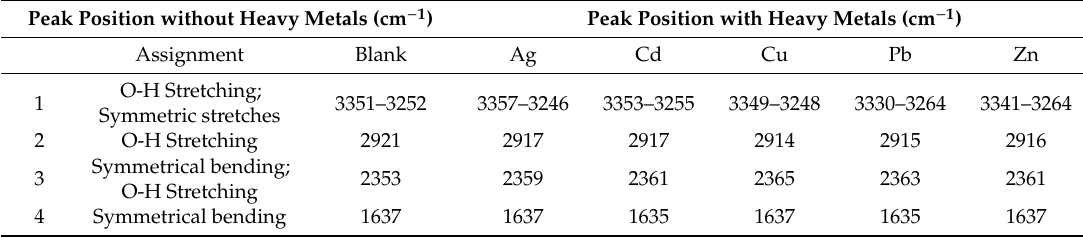
Table 1. Bands width and the peak positions in the Attenuated Total Reflectance (ATR) / FT-IR spectra. Peak Position without Heavy Metals (cm − 1 ) Peak Position with Heavy Metals (cm − 1